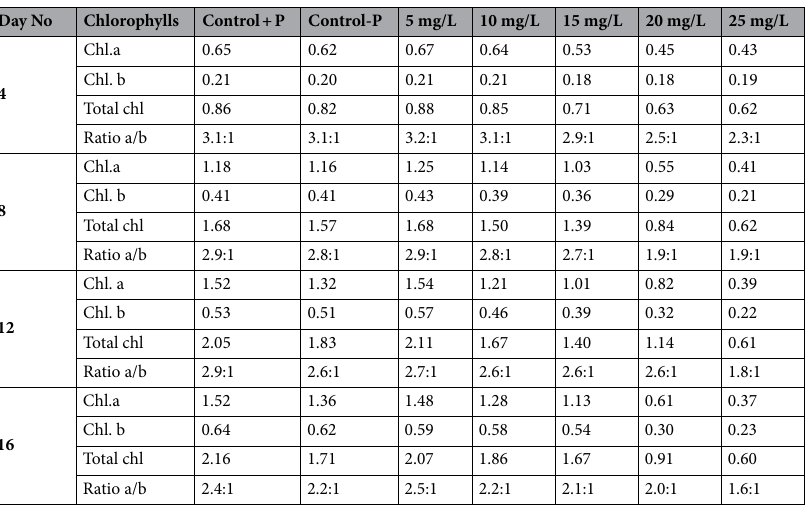
Table 2. Effect of different concentrations of dissolved nickel (mg/L) on chlorophylls content (µg/ml) of Dunaliella tertiolecta under the stress of phosphorus